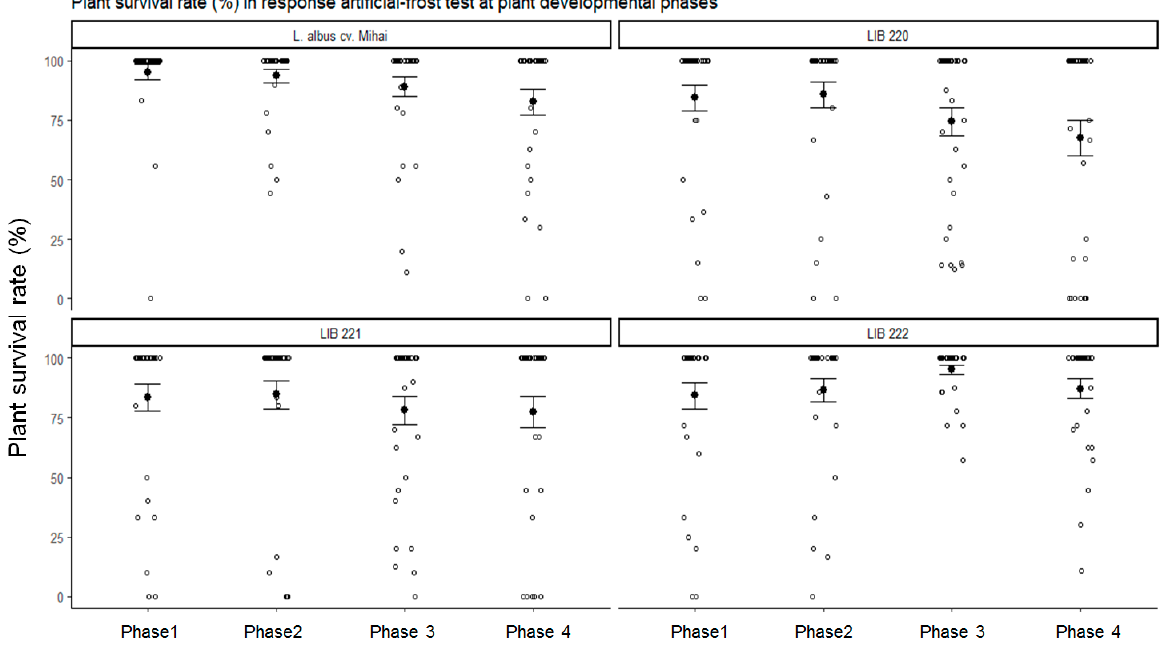
Figure 4. Evaluation of plant developmental phases with regard to accession and impact frost stress on seedlings. Phase 1—cotyledons at breaking soil surface phase (cotyledon); Phase 2—cotyledons fully above the soil; Phase 3—first leaves visible and erect but folded; and Phase 4—first and second leaves have unfolded. Each dot represents the mean survival rate (%) of the 10 biological replicates, from one of the six containers, per genotype x developmental phases comparison across all test temperatures.